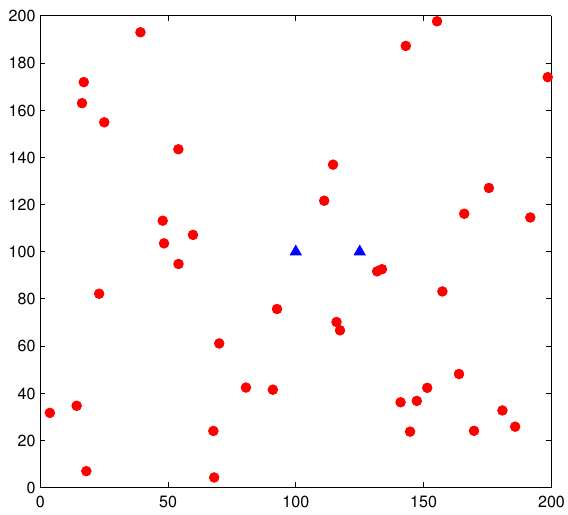
Figure 4. Random topology of a simulation snapshot of underwater cognitive acoustic sensor networks (UCANs), where red circles denote PUs and blue triangles denote SUs. Table 1. Deviation of p s con between simulation results (with different values of Ω ) and analytical